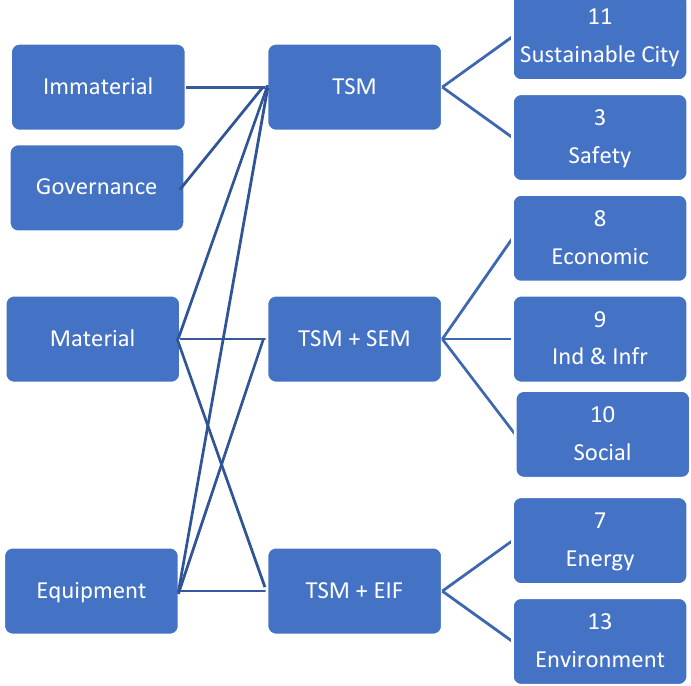
Figure 5. Policy interventions to Agenda 2030 Goals, through TSM, SET, EIF.